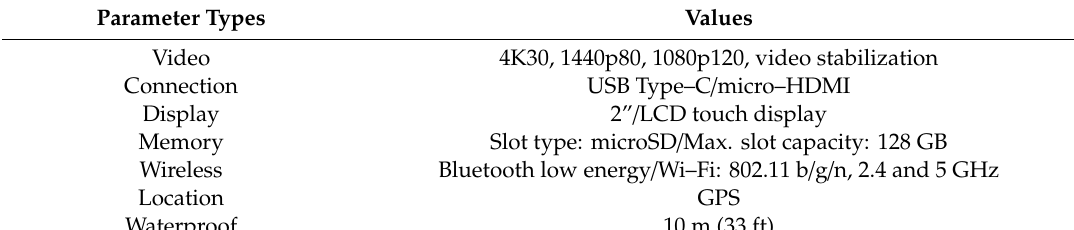
Figure 5. Data collection scenarios. Table 1. Technical parameters of the camera.